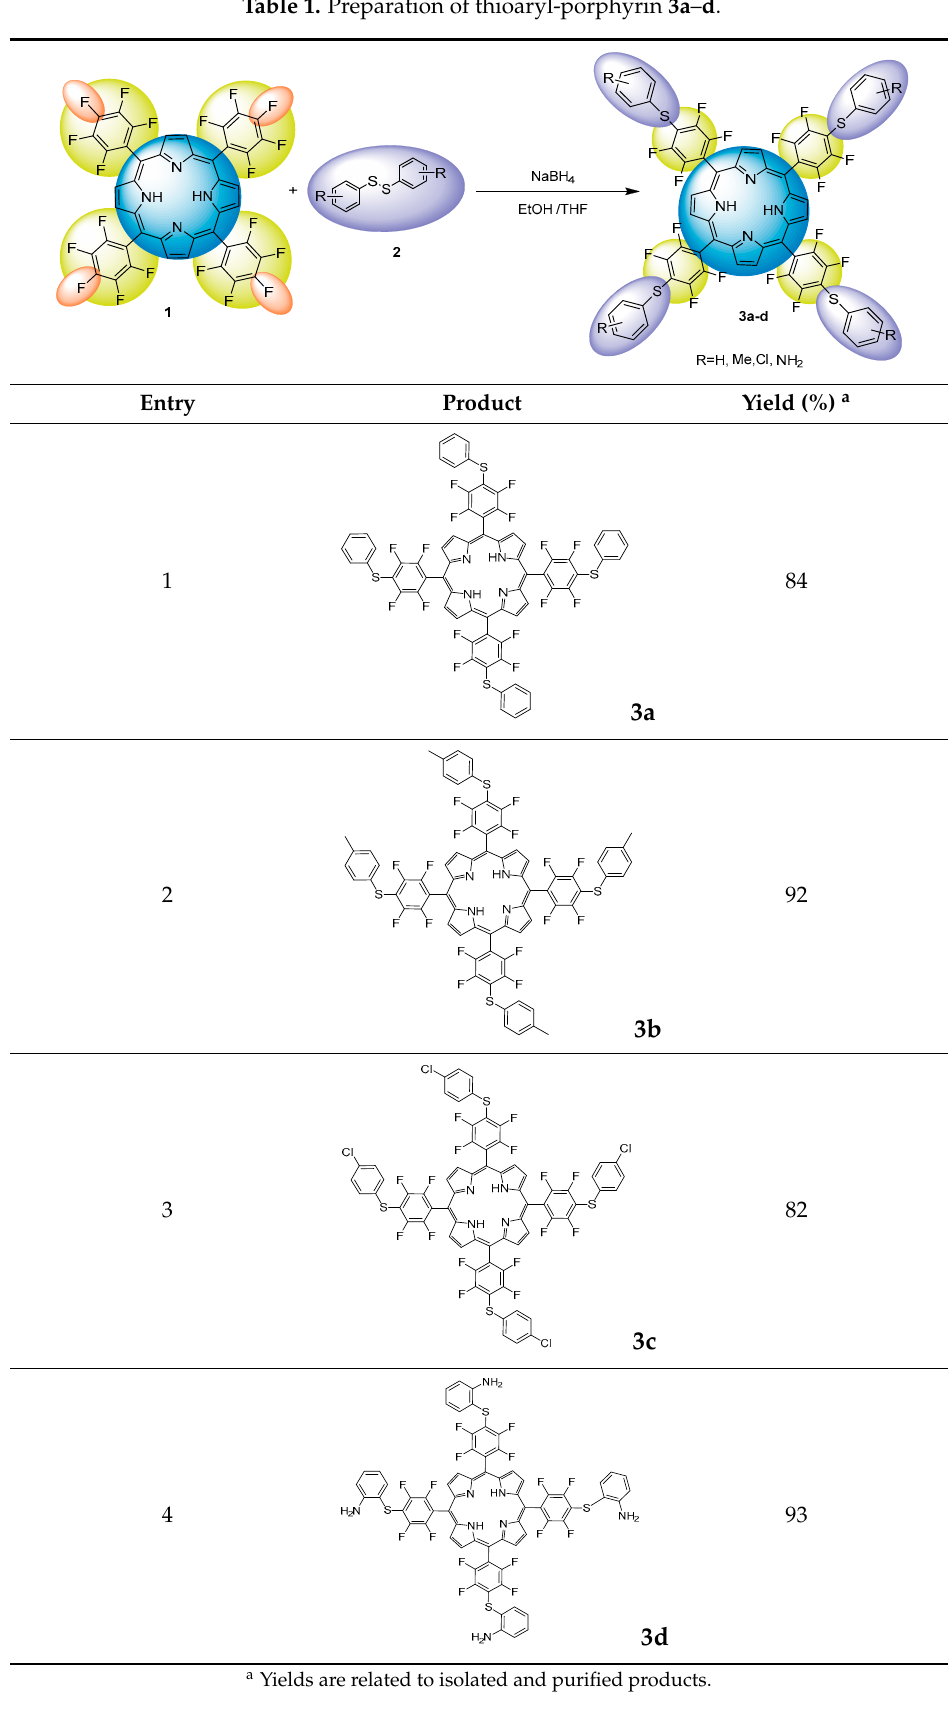
Table 1. Preparation of thioaryl-porphyrin 3a – d .